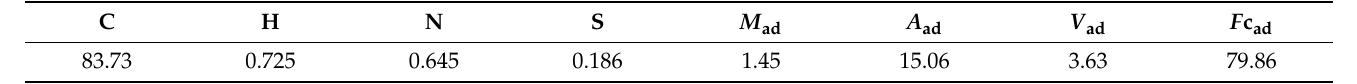
Table 1. Chemical composition of raw materials/wt.%.